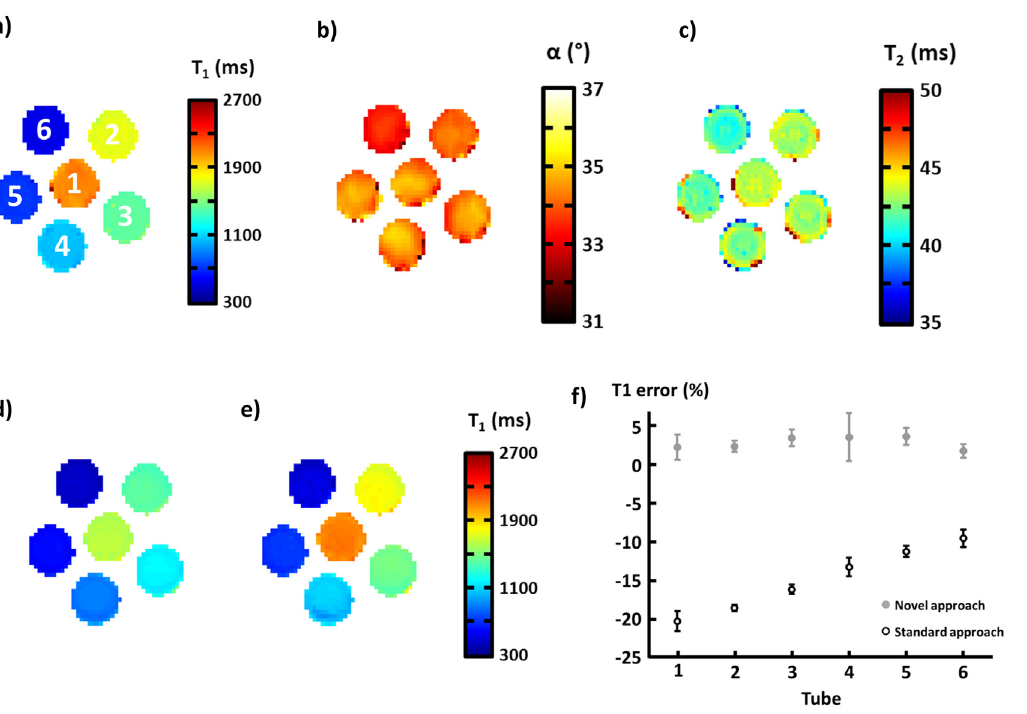
Fig 5. T1 (a), B1+ (b) and T2 (c) maps acquired on Gd-DOTA-doped phantoms using gold-standard sequences. T1 maps derived by the standard post-processing approach of the MOLLI sequence (d) and the novel simulation method (e). Mean relative errors between T1 values derived from gold standard sequence and the two different post-processing approaches of MOLLI sequence (f).